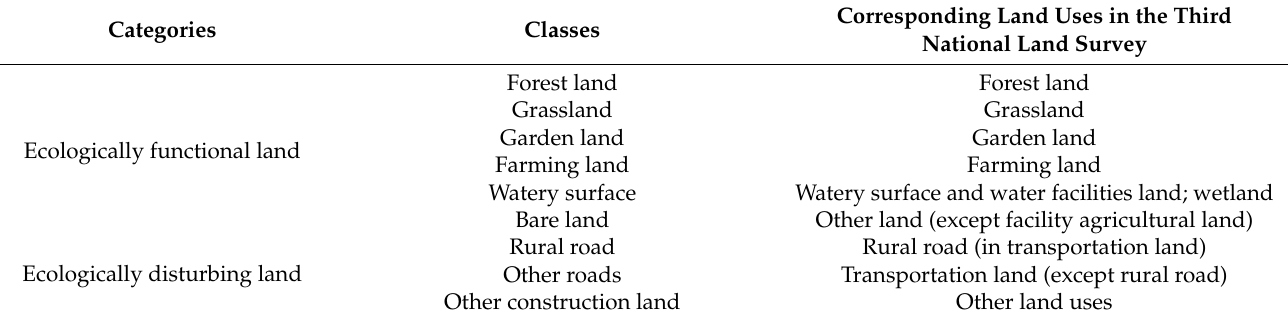
Table 1. Classification of land